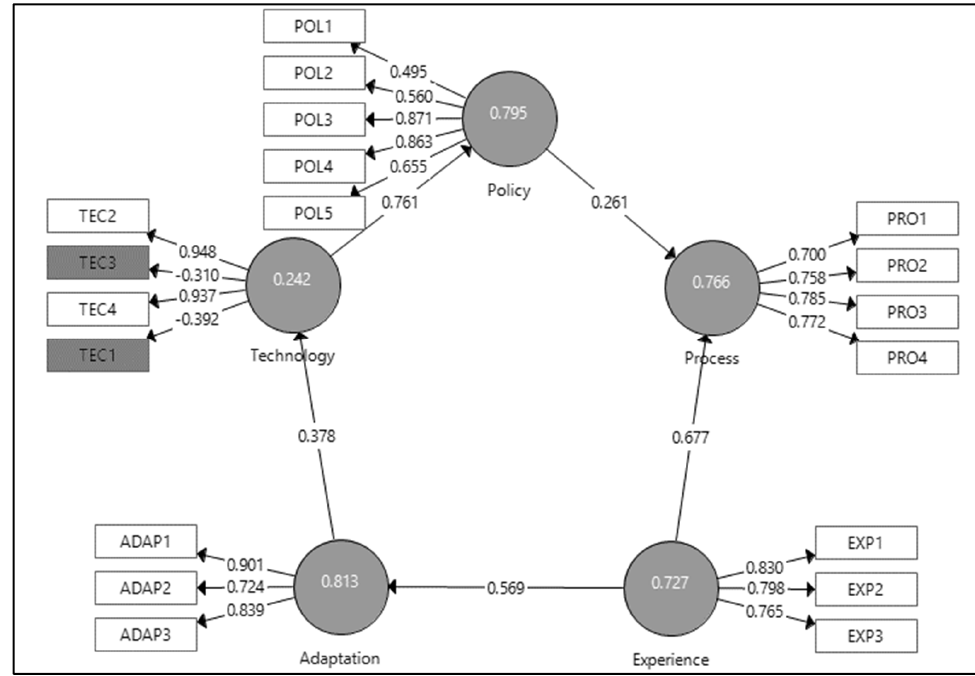
Figure 4. The first model obtained to characterize BIM users.